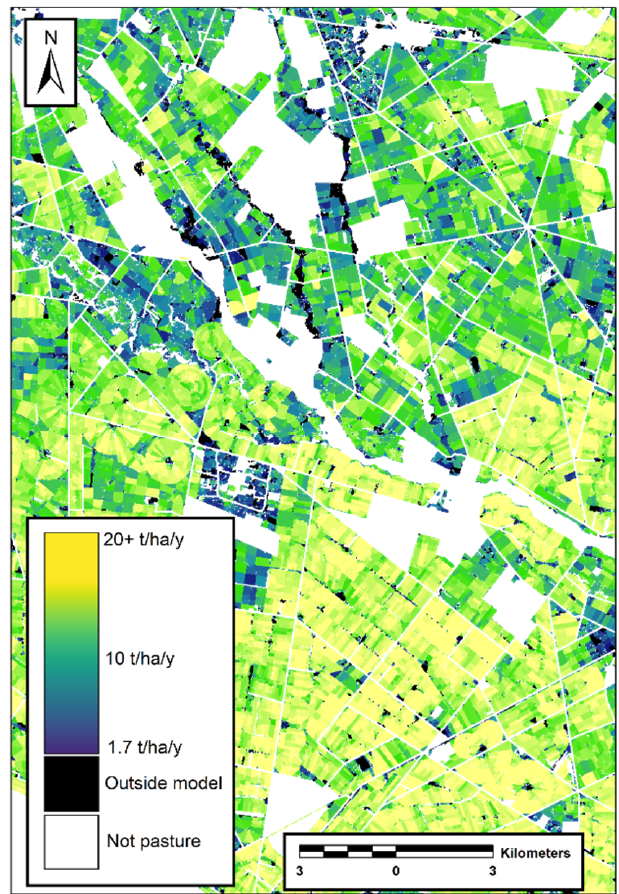
Figure 10. Pasture yield in Mid-Canterbury. White areas are outside LCDB pasture areas or are non-pasture polygons such as roads or buildings. Table 2. Regional pasture yield in New Zealand. Pasture fields are all fields within LCDB pasture boundaries, while production fields are those with yield large enough to be modelled. Pasture Region